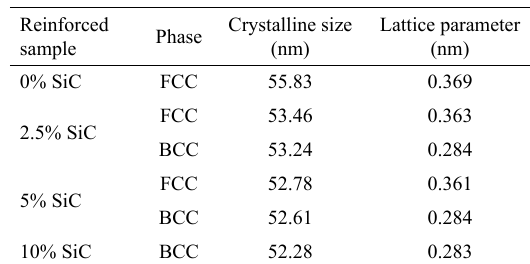
Table 1: Structural characteristics of the sintered samples AlCoNi alloy reinforced with SiC